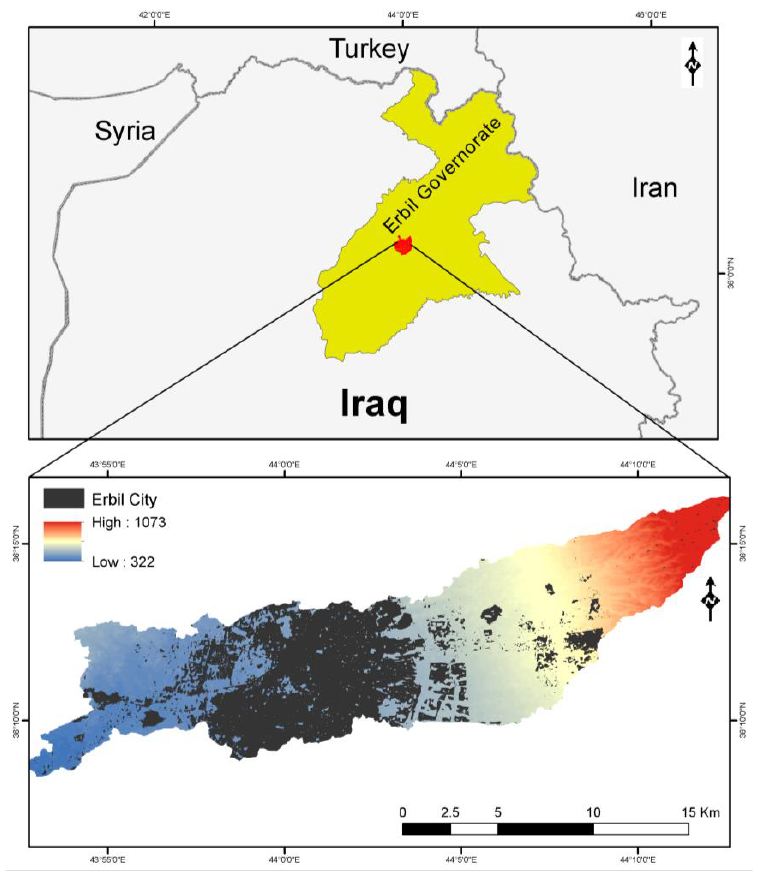
Figure 1. Location of the study area.